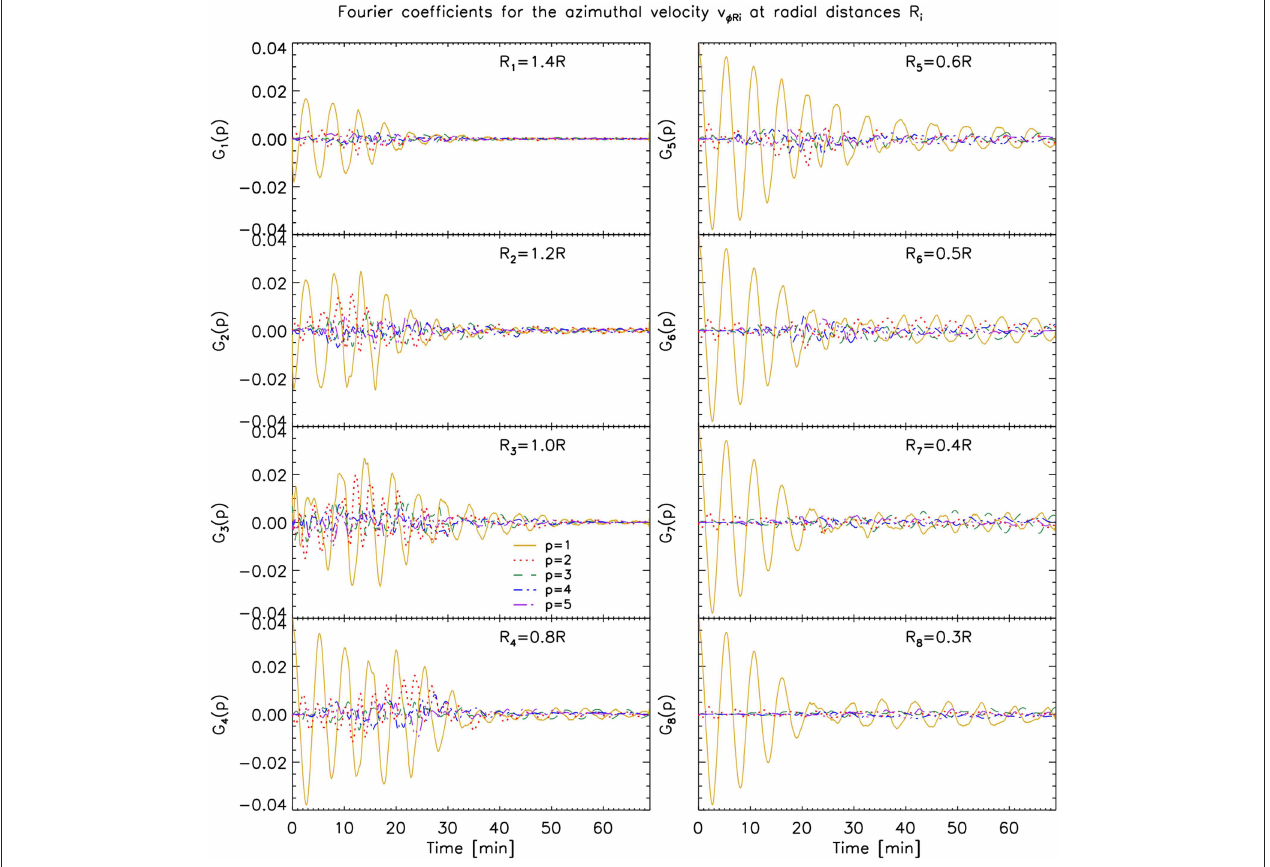
FIGURE 8 | Fourier coefficients for the azimuthal velocity v φ R at radial distances R i for the case without initial boundary layer and no viscosity. We show the i contribution of the azimuthal modes to the azimuthal velocity along self-similar ellipses whose semi-minor axis has various lengths R i (as indicated in the panels). The semi-major to semi-minor axis ratio of all ellipses matches the ellipse fitting the edge of the loop at each time step (see text for further details). We show the first 5 azimuthal wave modes (see the legend for the corresponding line